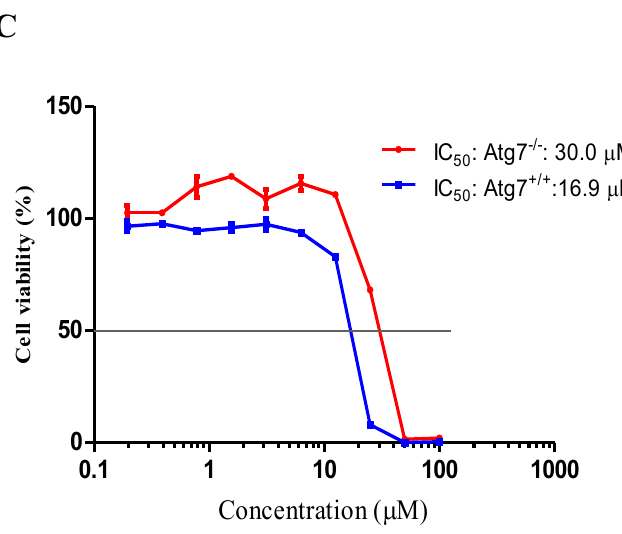
Figure 4. Neferine confers no obvious cytotoxicity at its effective working concentration. ( A ) PC-12 cells were stained with crystal violet for cell visualization after 24 h of neferine treatment (7.5 µM). Representative bright field images were captured (magnification: ×4). Scale bar: 150 µm. No significant difference in the percentage of cell viability was detected after measuring the absorbance (OD: 570 nm) of dissolved stained cells with or without the neferine treatments. ( B ) PC-12 cells were treated with neferine (7.5 µM) for 24 h. No significant difference in cell death was detected by annexin V staining using flow cytometry after neferine treatments. ( C ) Both wild-type Atg7 and Atg7-deficient MEF cells were treated with neferine from 0 to 100 µM for 48 h. The cytotoxicity (IC 50 value) of neferine was then measured by the MTT assay. Data from the bar chart represent the means ± SD of three independent